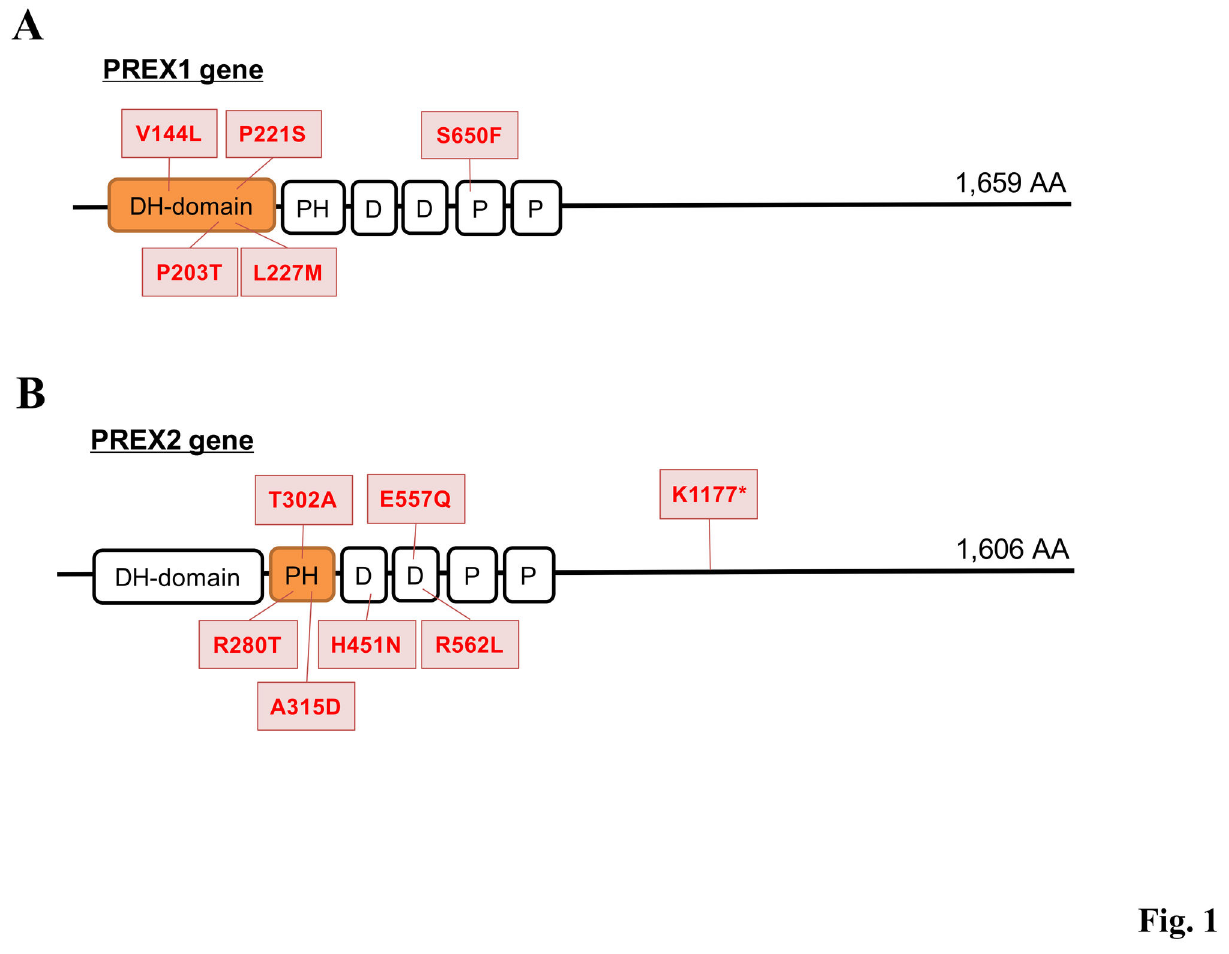
Figure 1. Identification and characterization of the putative cancer-related genes using 97 cancer exomes. SNVs in the PREX1 ( A ) and PREX2 ( B ) genes are represented in the boxes. The protein domains in which the enrichments of the SNVs were statistically significant are represented in orange boxes (also see Materials and Method). DH-domain: Dbl homology (DH) domain; PH: Pleckstrin homology domain; D: DEP domain; P: PDZ/DHR/GLGF. doi: